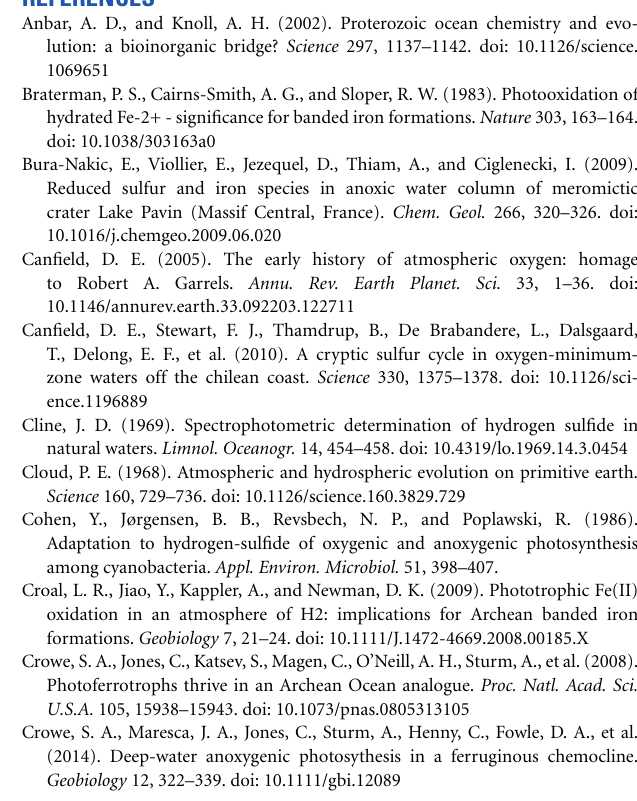
FIGURE 8 | Photomicrographs of (A) green and (B,C) purple anoxygenic phototrophs from the chemocline of Lake La Cruz. They show yellowish sulfur globules inside of PSB cells or